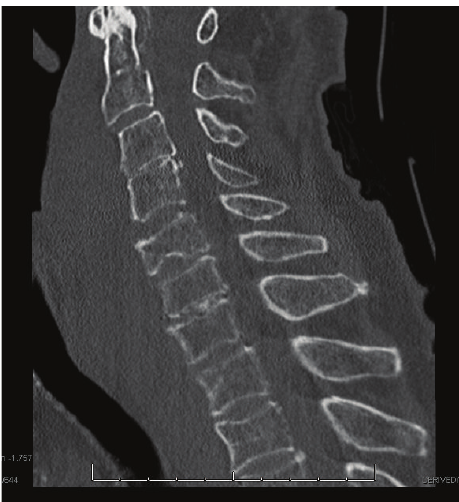
Figure 1: CT soft tissue of the neck without contrast showing prevertebral soft tissue swelling.